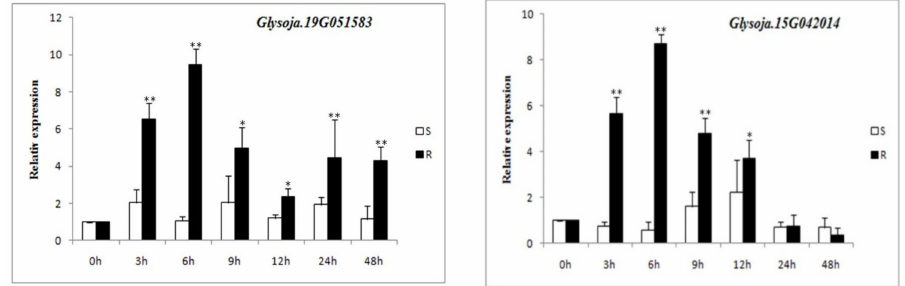
Figure 7. Relative expressions of candidate genes were induced by P. sojae . Note *: 0.05 level; **: 0.01